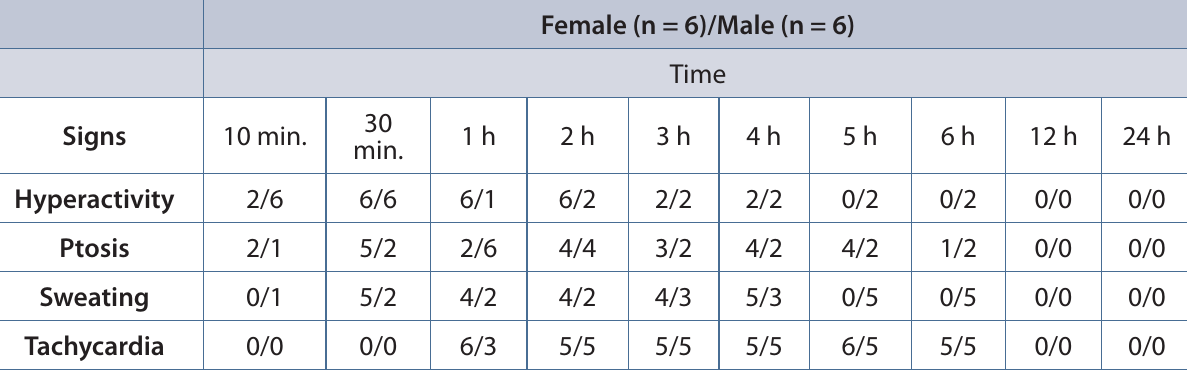
Table 3. Signs observed in 10-week-old female and male mice experimentally envenomed with Tityus serrulatus venom